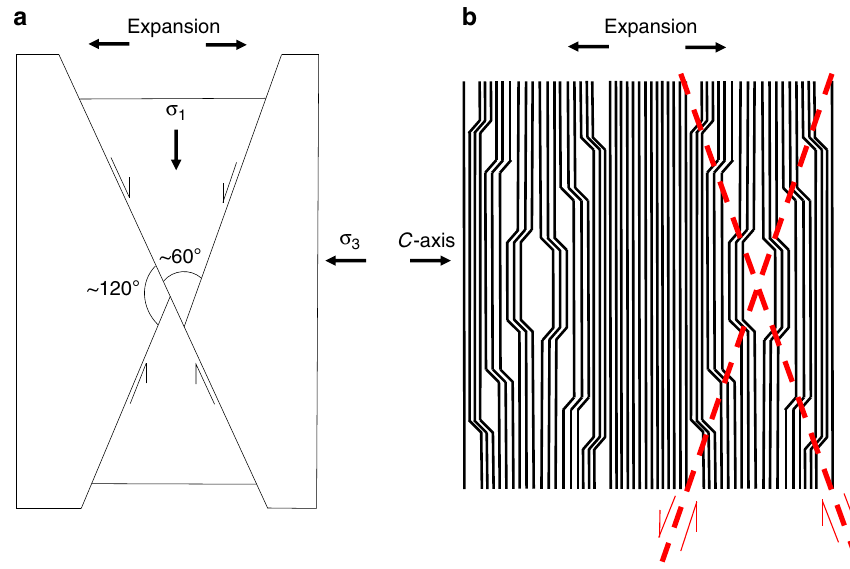
Fig. 4 Formation of conjugate arrays of expansion structures. Analogy between a the Anderson model of conjugate faulting and b a schematic representation of the conjugate arrays of expansion structures and delaminations we observe in biotite. In both cases structures (faults in a expansion structures in b ) form in two principal orientations, which are up to 60° apart and display opposite shear sense. The obtuse angle between the two orientations is bisected by σ 3 in a and the c -axis in b . In both cases this is the orientation along which expansion (or extension) occurs. In this way the diamond-shaped expansional arrays are crystallographically controlled as is evidenced by the fact that they have different orientations in different grains, being always aligned with the c -axis of each grain. Conjugate delamination arrays represent the most ef fi cient way to relieve stored grain-scale c -axis strain energy, just as conjugate normal faults result from extension on a larger scale. The orientations of principal stresses in this fi gure are therefore representative of the time when stored elastic strain energy is released (during thinning for TEM), not necessarily the time during which strain was being accumulated (deformation within the viscous shear